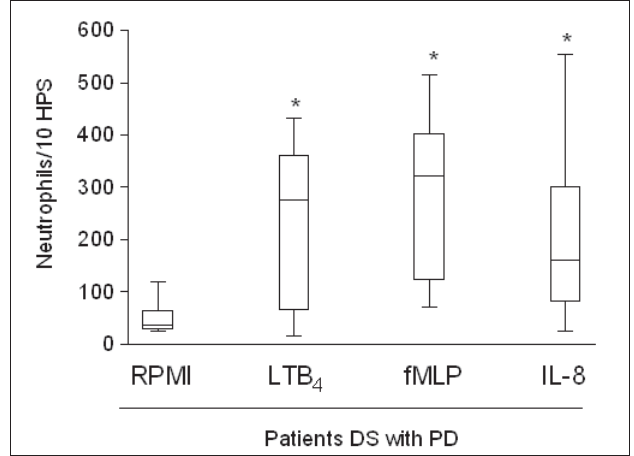
Fig. 5 - Chemotactic migration function of neutrophils from Down syndrome patients with periodontal disease. The figure represents emigrated neutrophils in response to RPMI (random migration) or to chemotactic stimulation with LTB (10 -7 M) and IL-8 (10 -9 M). *Statistically significant difference (p<